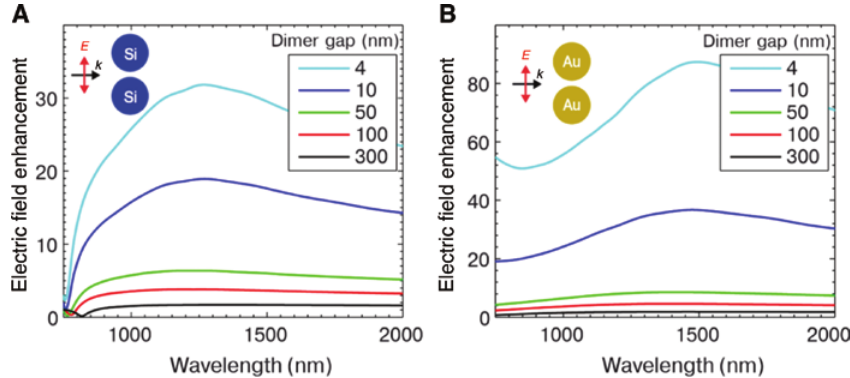
Figure 5: Comparison of the electric field enhancement of dielectric and metallic dimers. (A) Near-field enhancement of the electric field amplitude as a function of wavelength calculated at the center of the gap in a silicon dimer with different separation distances. (B) Same as in (A) but for a gold dimer. Reprinted with permission from [33]. © Copyright 2013 American Chemical